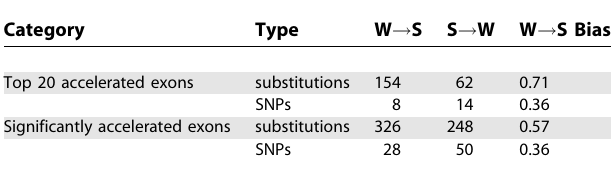
Table 3. Patterns of Nucleotide Substitutions Compared with SNPs in Human-Accelerated Exons